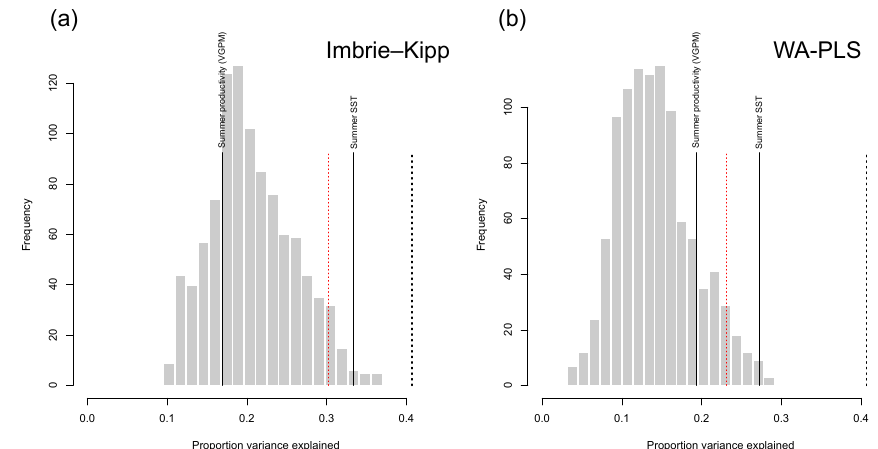
Figure 5. Results of the significance test of assemblage-based palaeoenvironmental reconstructions using the R package palaeoSig (Telford, 2015). The null distribution is produced by generating 999 random environmental variables and reconstructing these variables from PF assemblages of core SL163 using (a) the Imbrie–Kipp method (IK) and (b) the weighted-averaging partial-least-squares (WA-PLS) method. Grey shaded histograms indicate the amount of variance of the fossil data explained by the 999 random environmental variables, whereas the black vertical lines indicate the variance explained by the reconstruction of summer productivity (VGPM) and summer SST using the different methods. The red dashed line represents the 95th percentile of the null distribution; the black dashed line represents the variance explained by the first RDA axis. Thus, the proportion of variance explained by the IK method for the reconstruction of summer SST from the fossil dataset is higher than 95% ( p = 0 . 015) of reconstructions of 999 random environmental variables. The summer SST reconstruction from the WA-PLS method is higher than 99% of the random reconstructions ( p = 0 . 007). The VGPM-based reconstruction of summer surface primary productivity is not significant (IK: p = 0 . 76; WA-PLS: p = 0 .